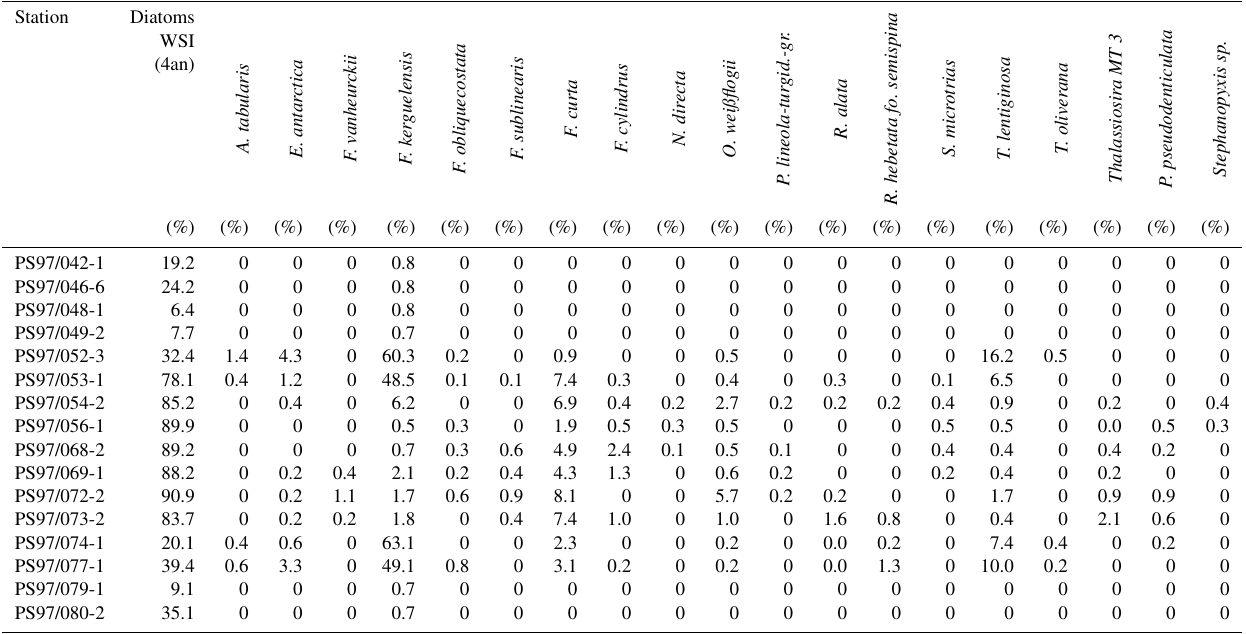
Table 4. Estimations of winter sea ice (WSI) derived from diatom species and the distribution of main diatom species in each sample. Station Diatoms